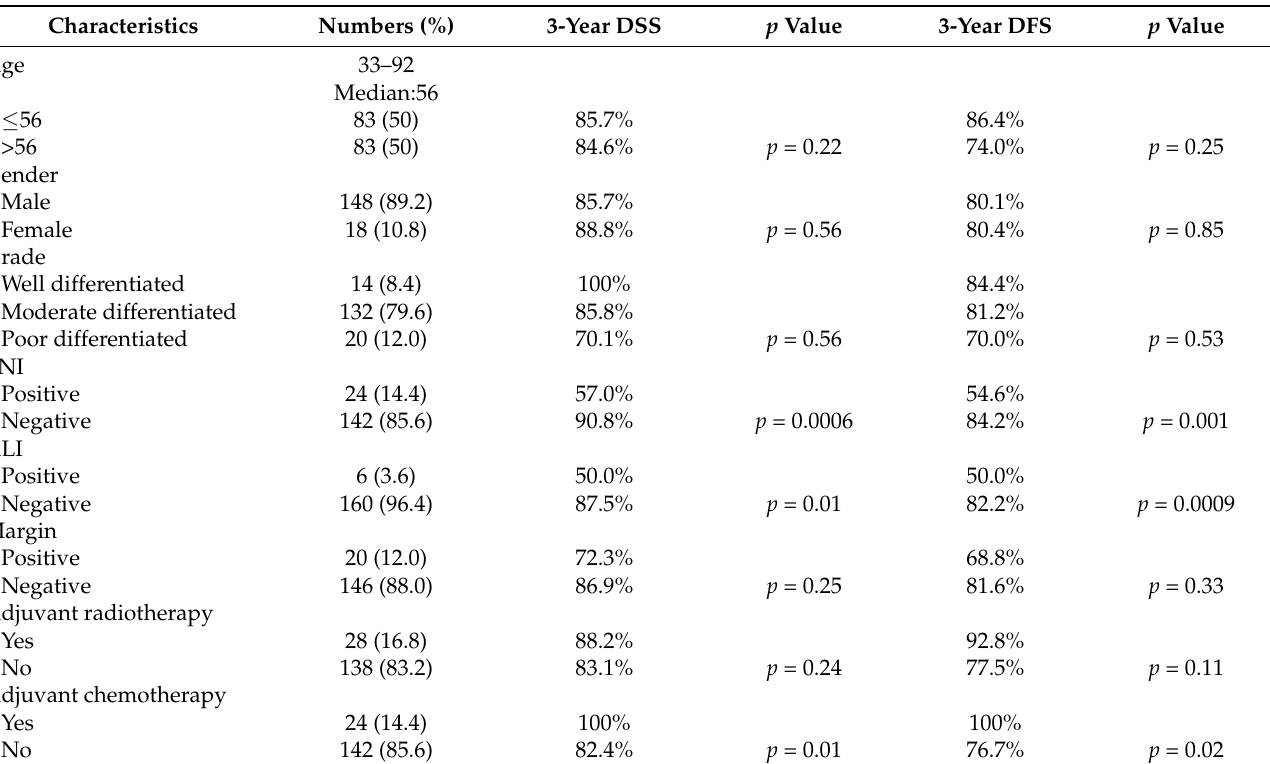
Figure 1. Kaplan–Meier disease-specific survival curve according to peri-neural invasion status in 166 patients with T2N0 OSCC.